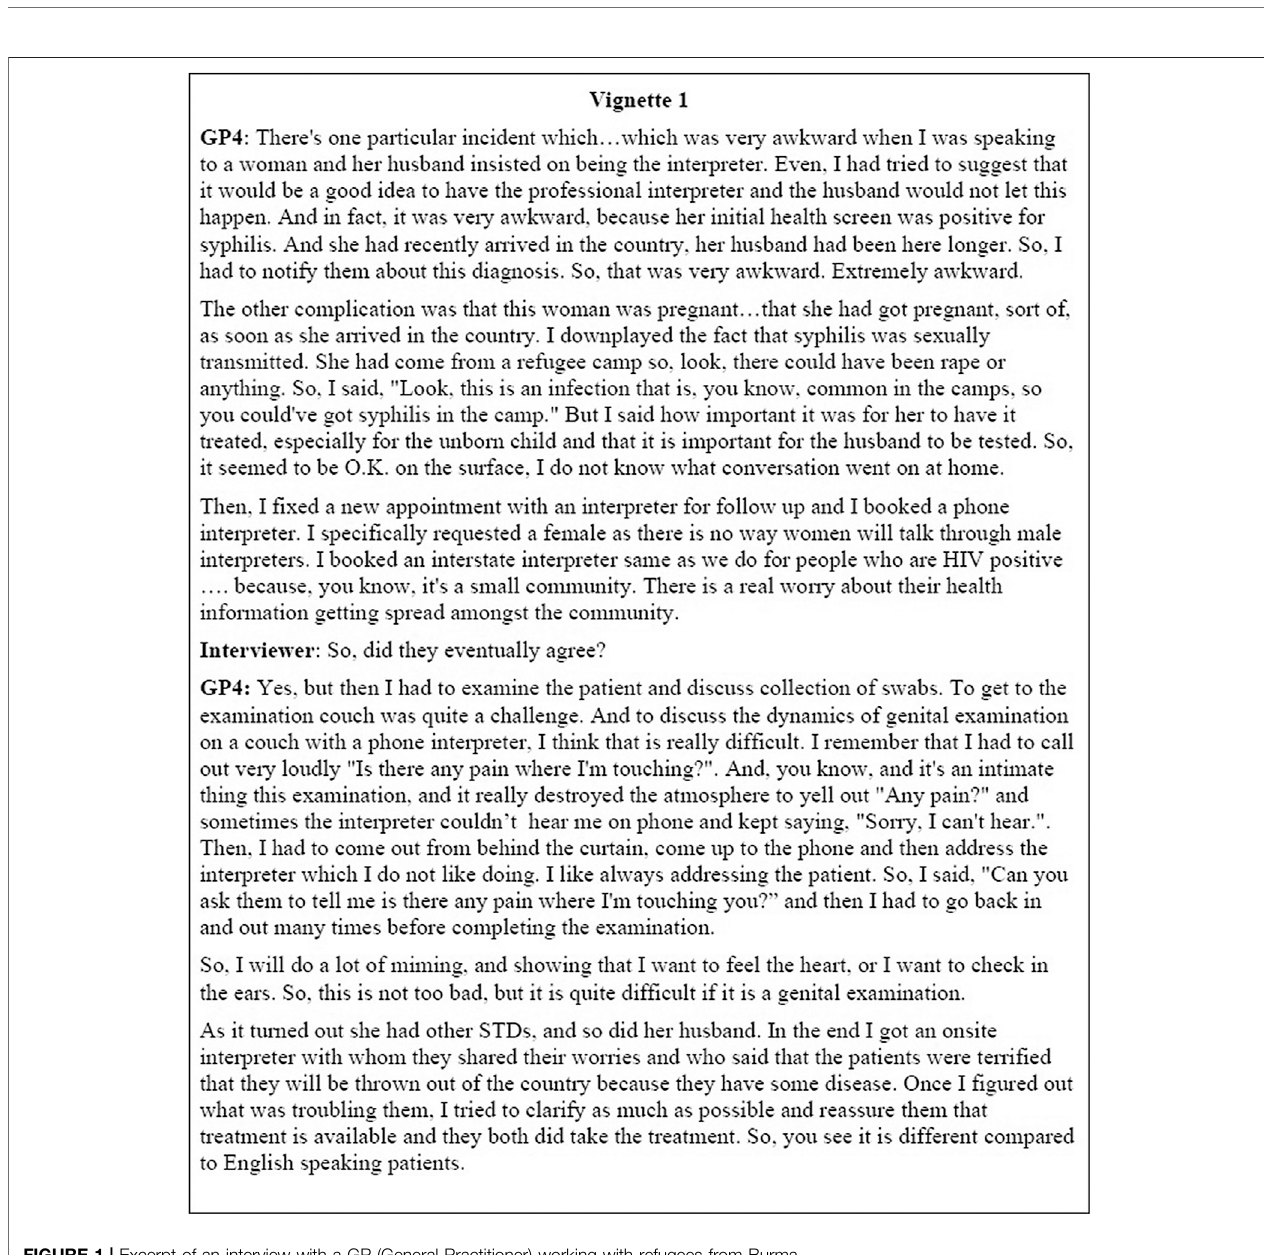
FIGURE 1 | Excerpt of an interview with a GP (General Practitioner) working with refugees from Burma.